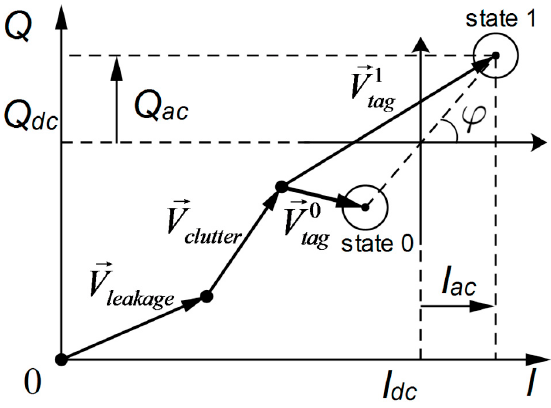
Figure 3. Tag response on the I–Q vector plane [47].